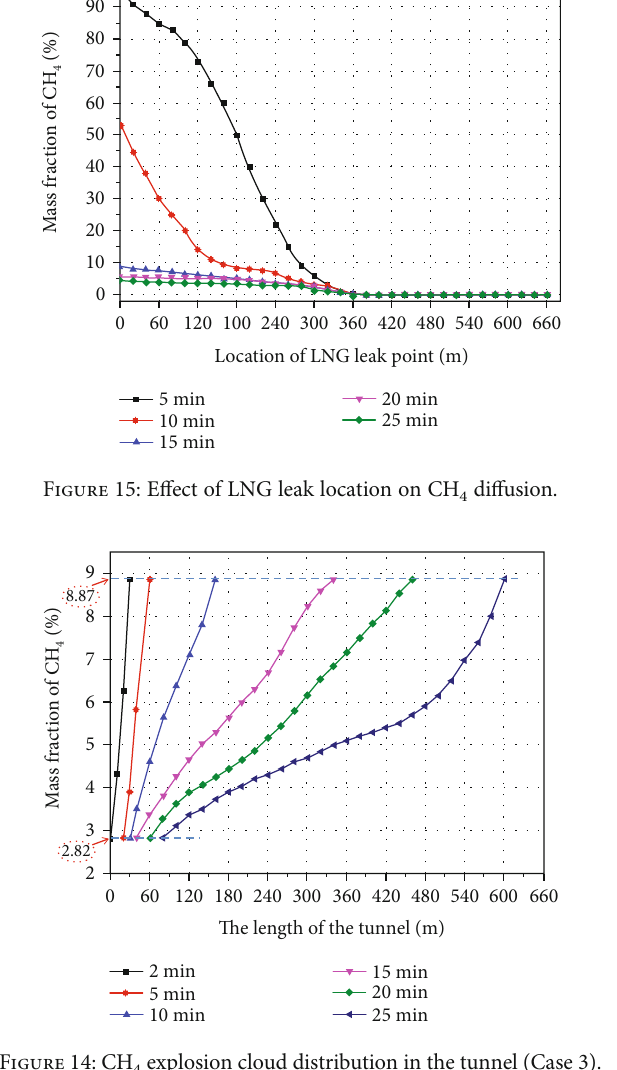
Figure 14: CH explosion cloud distribution in the tunnel (Case 4